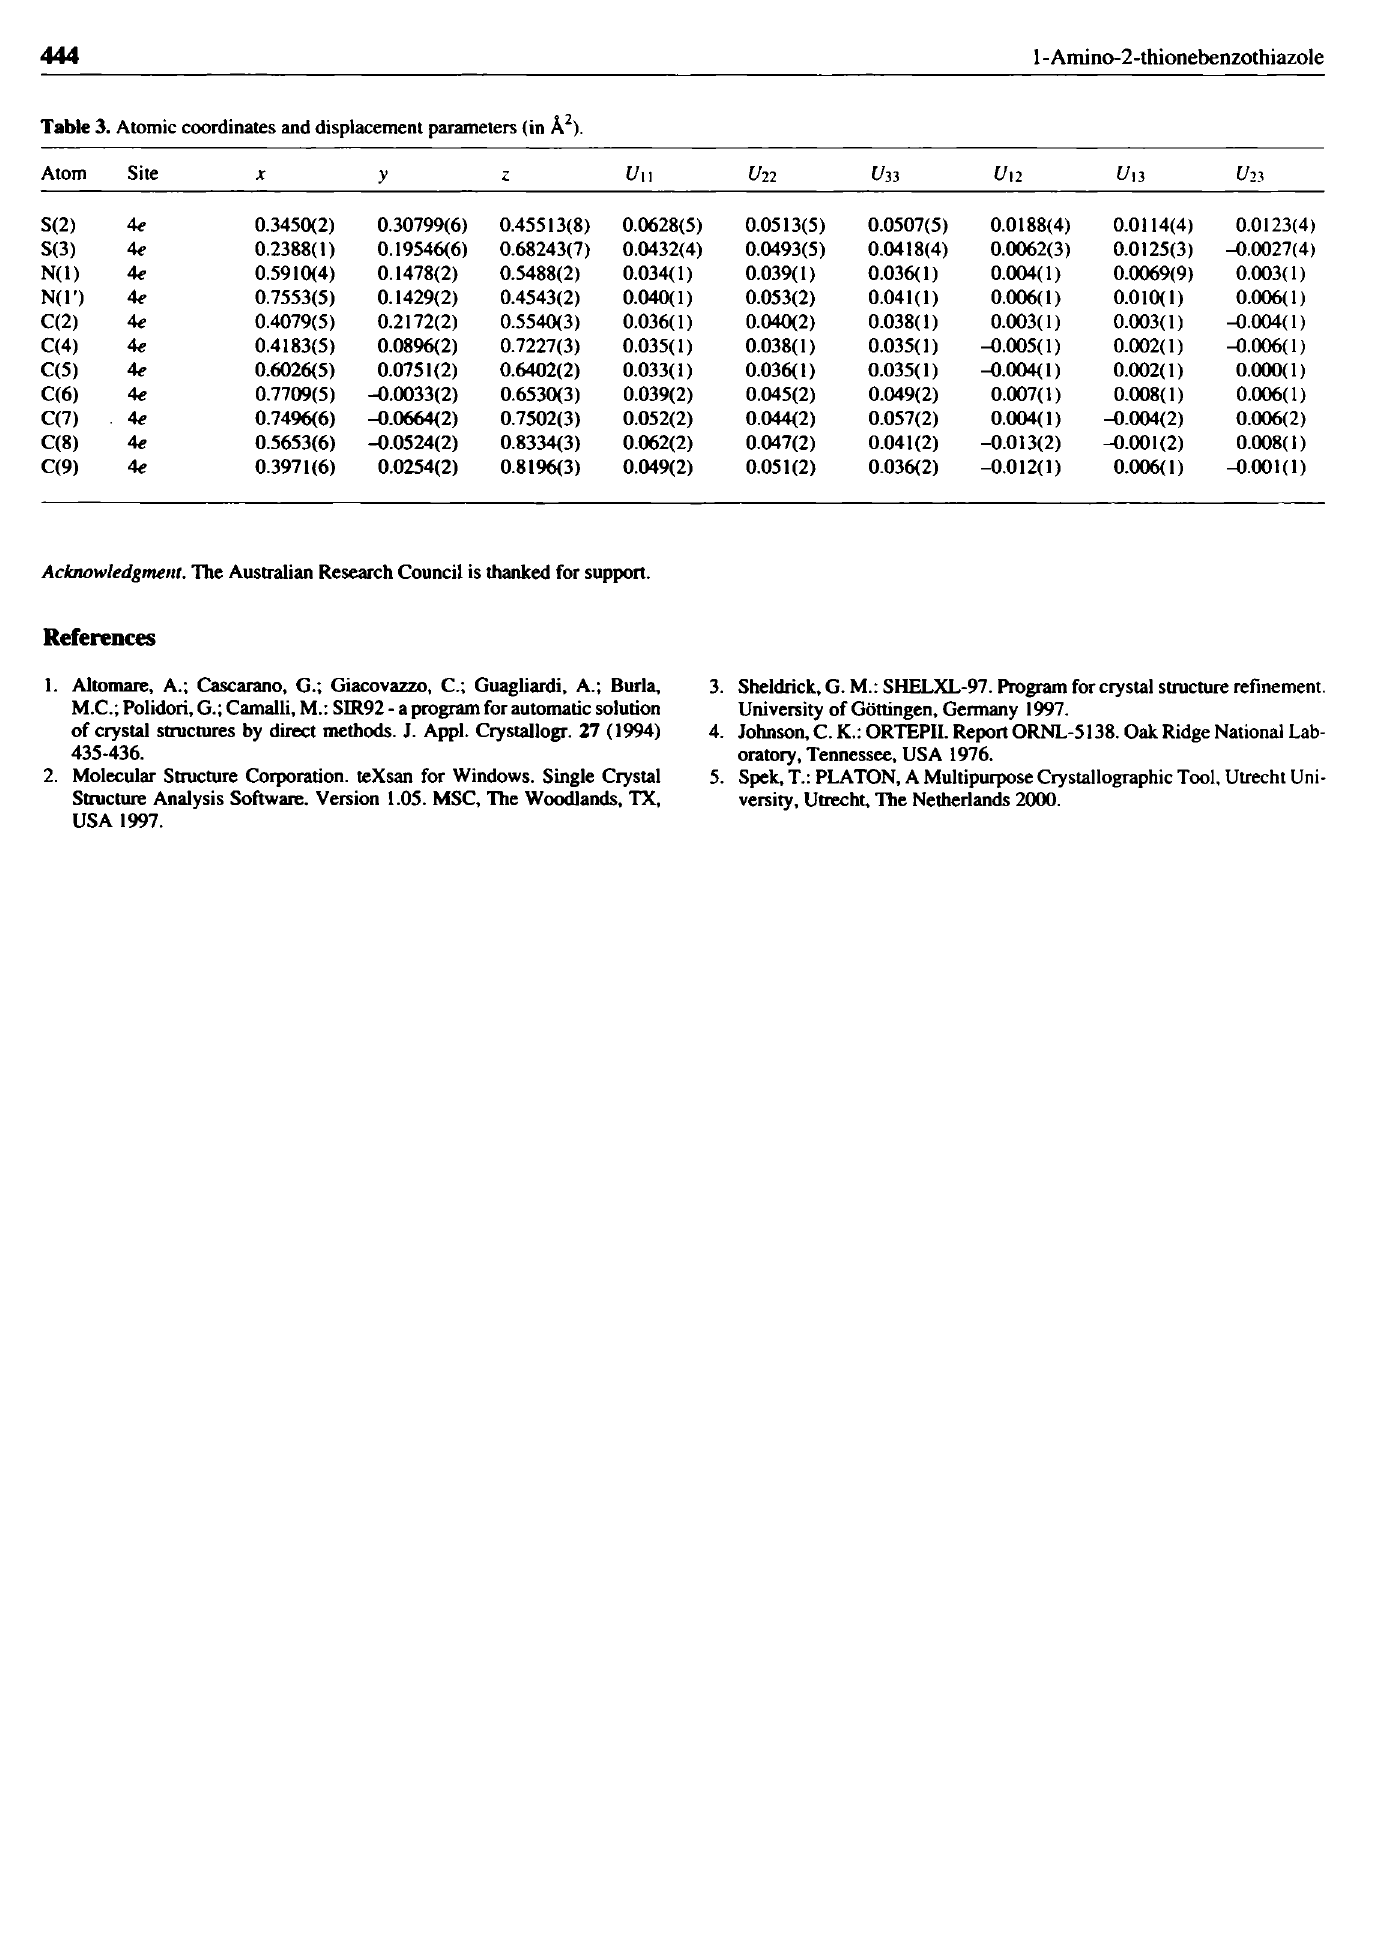
Table 3. Atomic coordinates and displacement parameters (in Ä 2